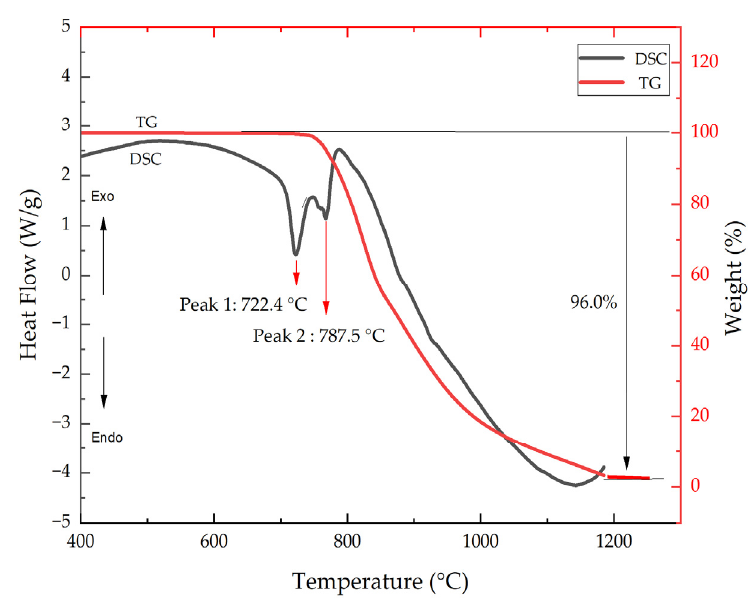
Figure 1. TG/DSC curve of molybdenum trioxide pyrolysis.